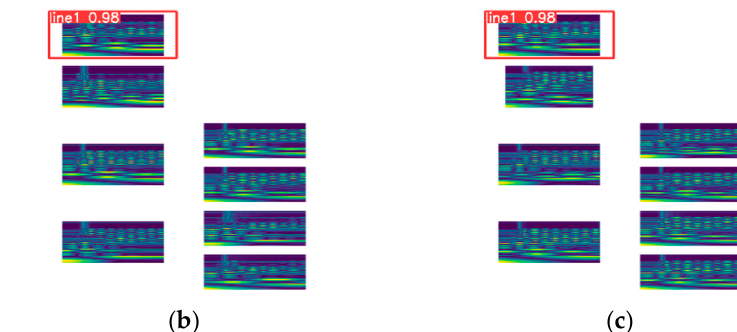
Figure 15. Identification of the confusion matrix.